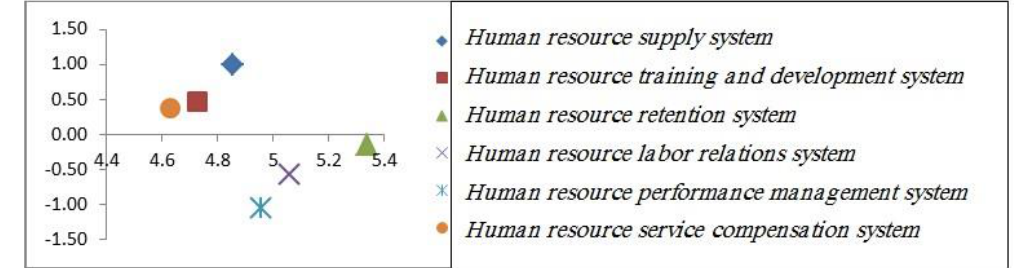
Fig. 2. The cause-effect relations between the main problems.